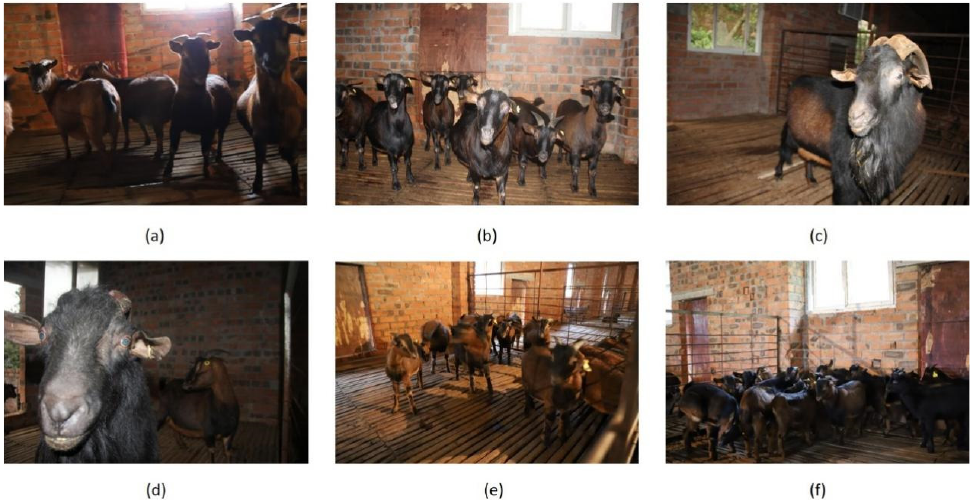
Figure 2. Some acquired images of Chengdu ma goats. It can be seen that the Chengdu ma goats are densely distributed in some of the images, and the body scale varies drastically in different images. ( a ): An image of ewes with poor lighting. ( b ): An image of ewes with good lighting. ( c ) An image of a ram with good lighting. ( d ) An image of a ram with poor lighting. ( e ) An image of lambs with good lighting. ( f ) An image of lambs with poor lighting.